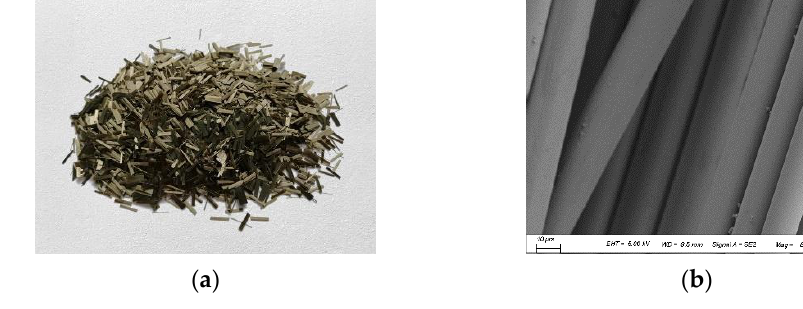
Figure 1. Basalt fiber: ( a ) Macro image; ( b ) Micro image.